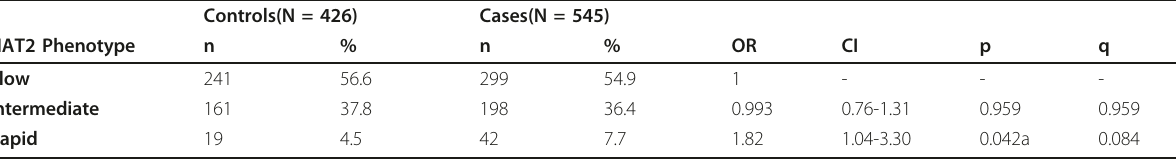
Table 5 Comparisons Between NAT2